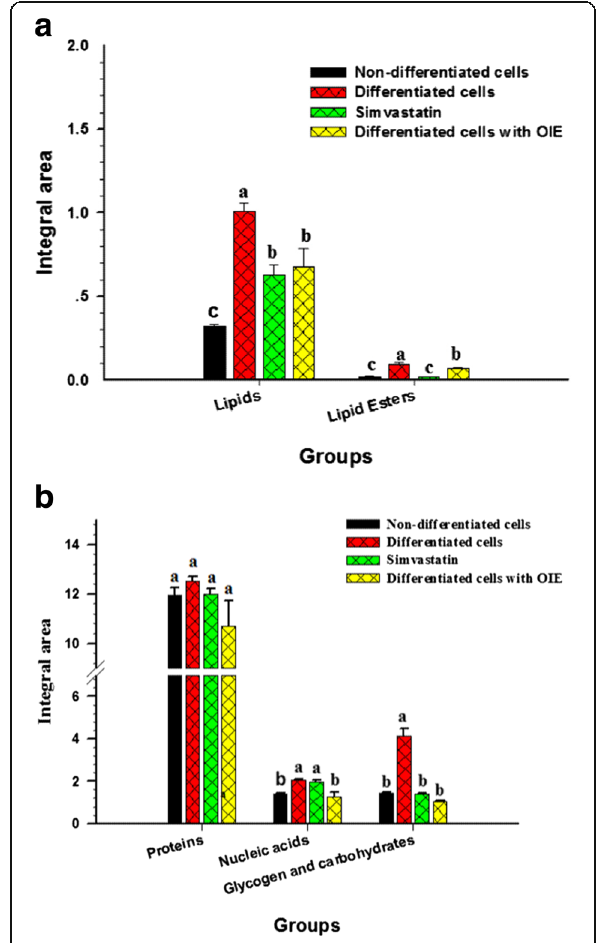
Fig. 7 The histogram of integrated areas of 3T3-L1 cells. The integrated area from second derivative data of non-differentiated cells (pre-adipocytes), differentiated cells, simvastatin- and Oroxylum indicum extract-treated differentiated cells. Integral area of lipids and lipid esters ( a ). Integral area of proteins, nucleic acids, glycogen and carbohydrates ( b ). The results reported as means ± SEM ( n = 3). Significant differences were observed (Tukey ’ s HSD test, p < 0.05) and are represented on the figure with letters from a to